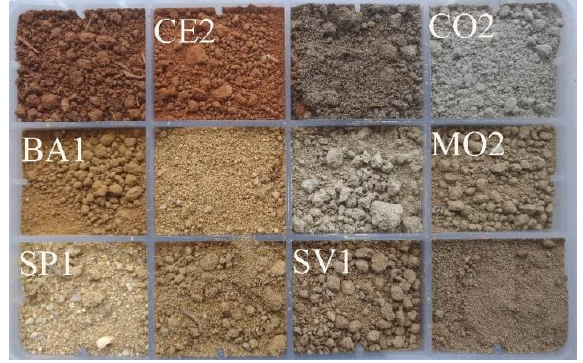
Figure 5. Taken earths, author's